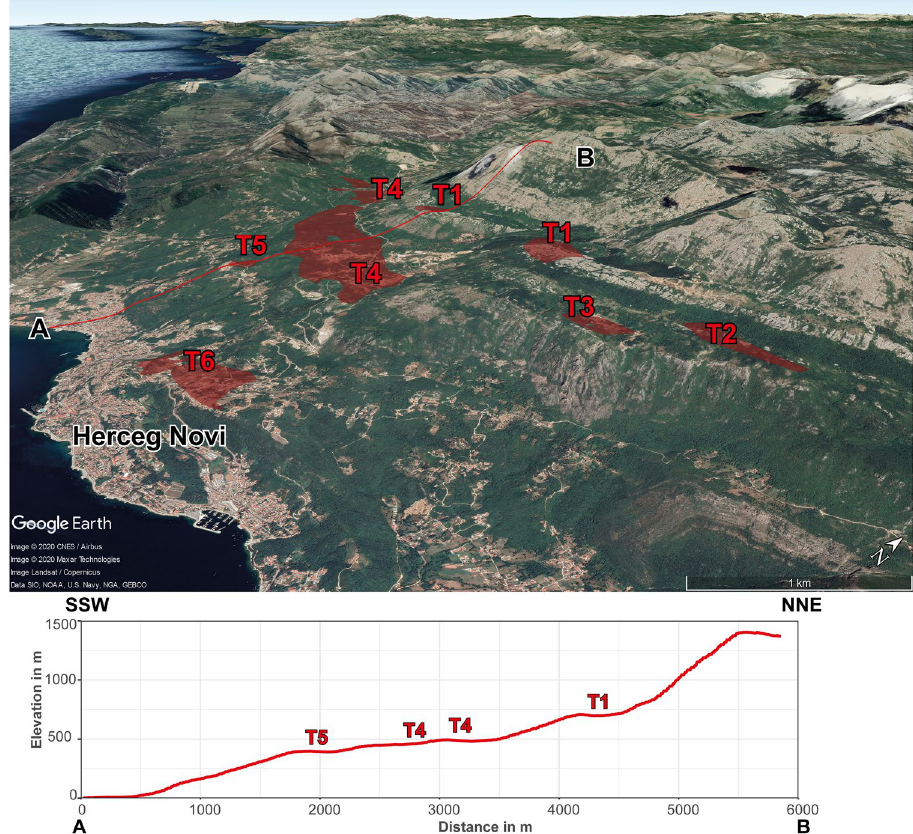
Figure 5. Staircase morphology in the southern External Dinarides. Satellite image draped on top of a DEM (Google Earth) of the southern External Dinarides in northwestern Montenegro. The mapped terraces are marked in red and annotated by their relative age, where T1 marks the oldest and T6 the youngest terrace. The lower panel shows the staircase morphology on a topographic profile A–B with the terraces annotated with their relative